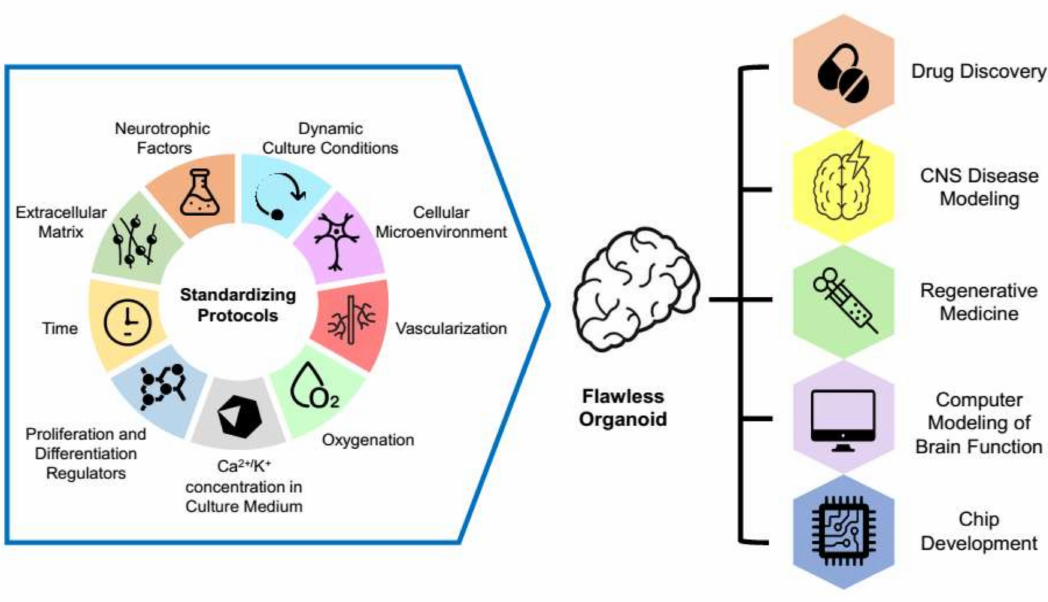
Figure 4. Current trends in development of cerebral organoid